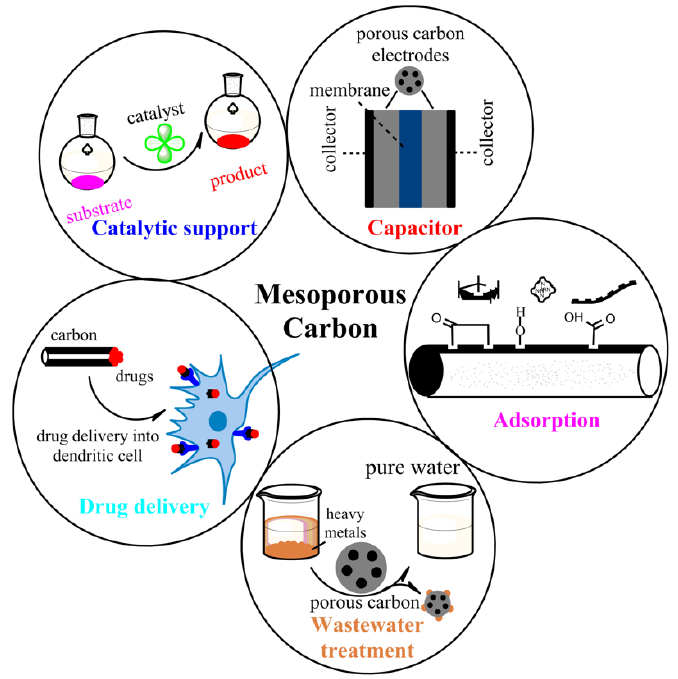
Figure 1. Potential applications of mesoporous carbon in modern scientific research. Table 1. Application of mesoporous carbon in various scientific disciplines.